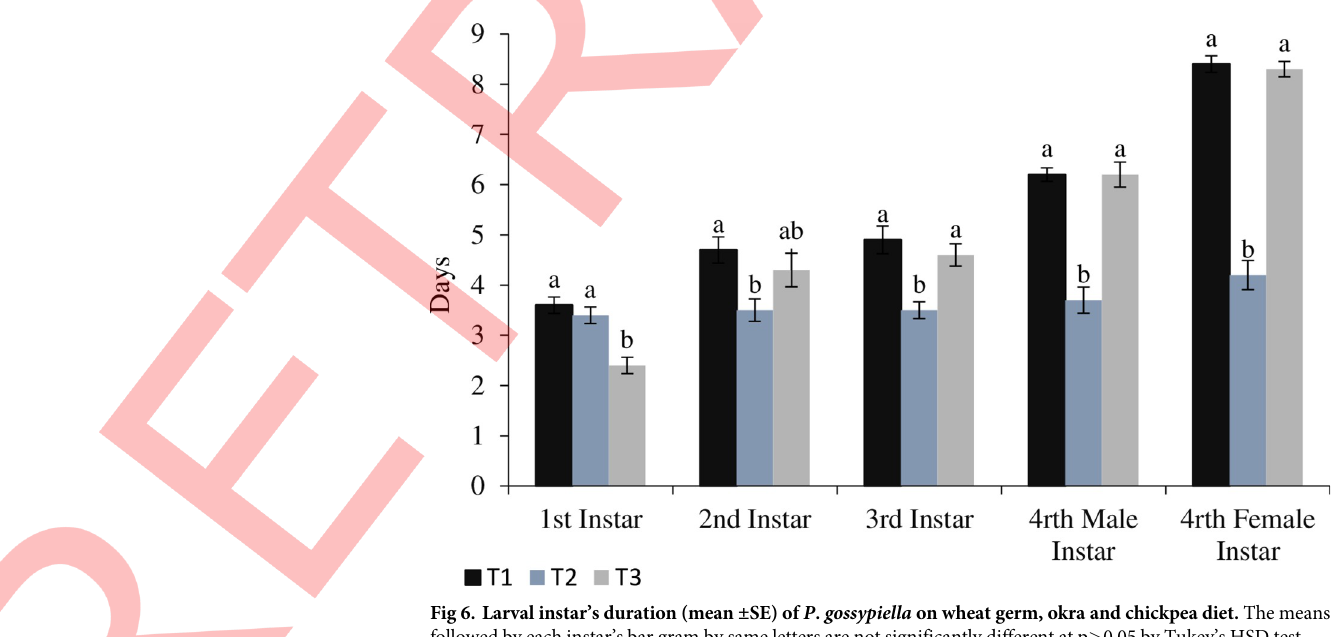
Fig 6. Larval instar’s duration (mean ± SE) of P . gossypiella on wheat germ, okra and chickpea diet. The means followed by each instar’s bar gram by same letters are not significantly different at p > 0.05 by Tukey’s HSD